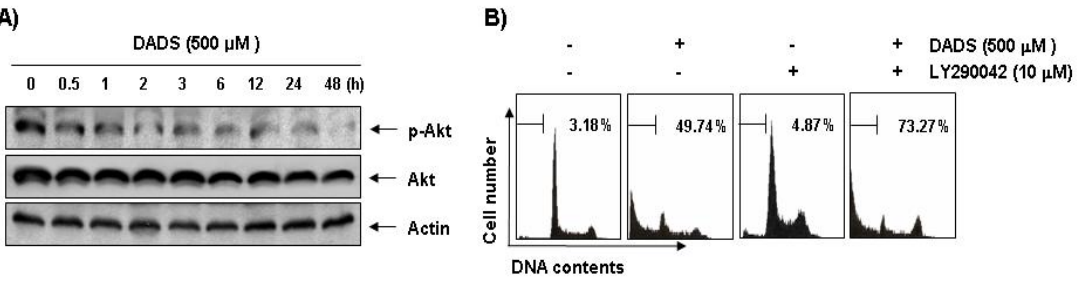
Figure 7. DADS triggers apoptosis through PI3K/Akt signaling in DU145 cells. ( A ) The cells were treated with DADS (500 µM) for the indicated times. Equal amounts of cell lysate were resolved by SDS-polyacrylamide gels, transferred to nitrocellulose membranes and probed with the anti-p-Akt and anti-Akt antibodies. The proteins were visualized using an ECL detection system; ( B ) The cells were stimulated with 500 µM DADS for 48 h after pretreatment of 10 µM LY290042 for 1 h. The degree of apoptosis was determined by